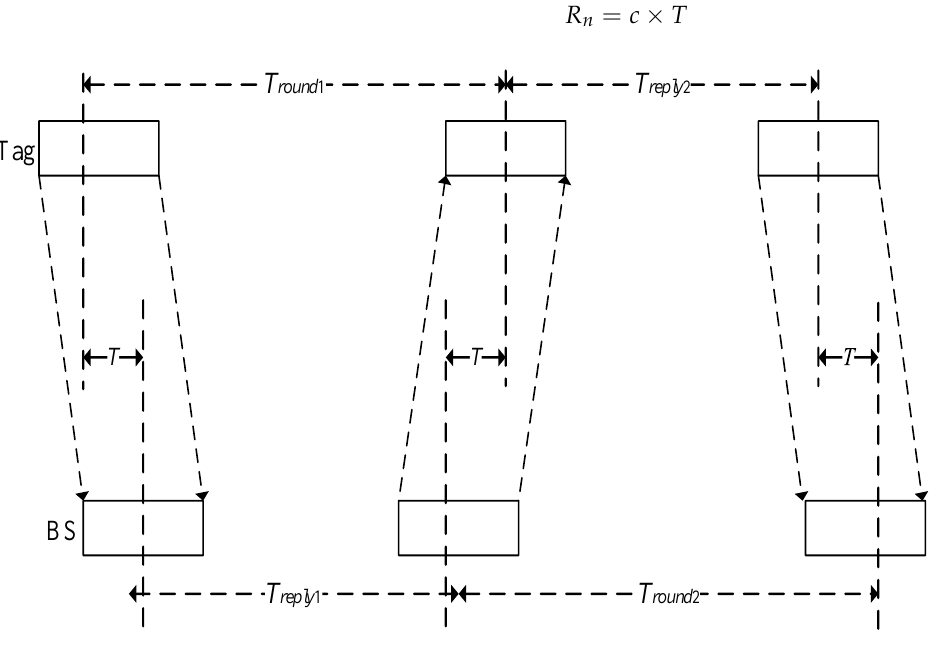
Figure 1. ADS-TWR positioning schematic diagram.